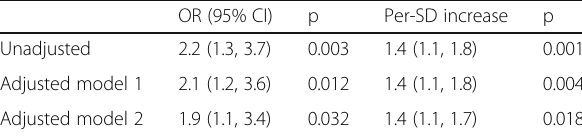
Table 2 Association between the admission 2OG levels and short-term